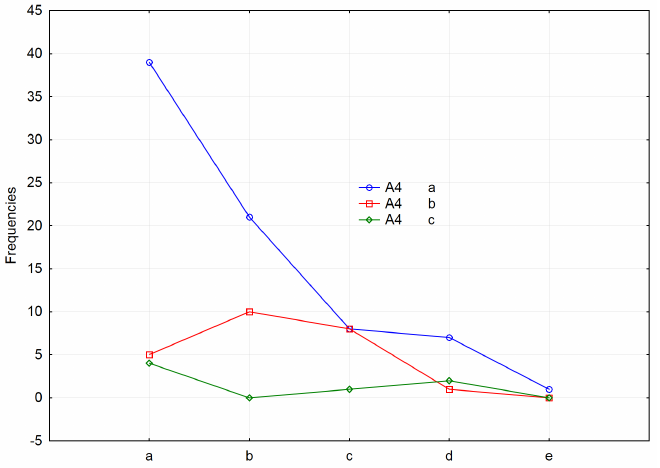
Fig. 2. Frequencies of the particular reasons (a – e) to incorporate digital means in teaching process stated by the group of foreign language teachers according to sub-category